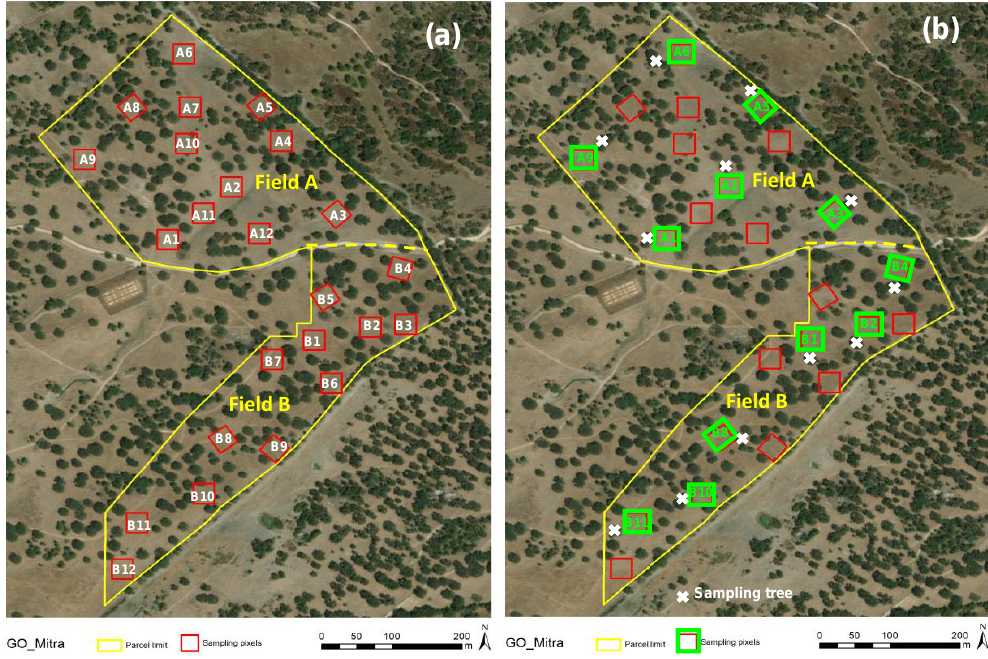
Figure 3. Sampling scheme of the experimental field in each phase of this study: ( a ) 24 sampling pixels; ( b ) 12 sampling pixels and 12 sampling trees.